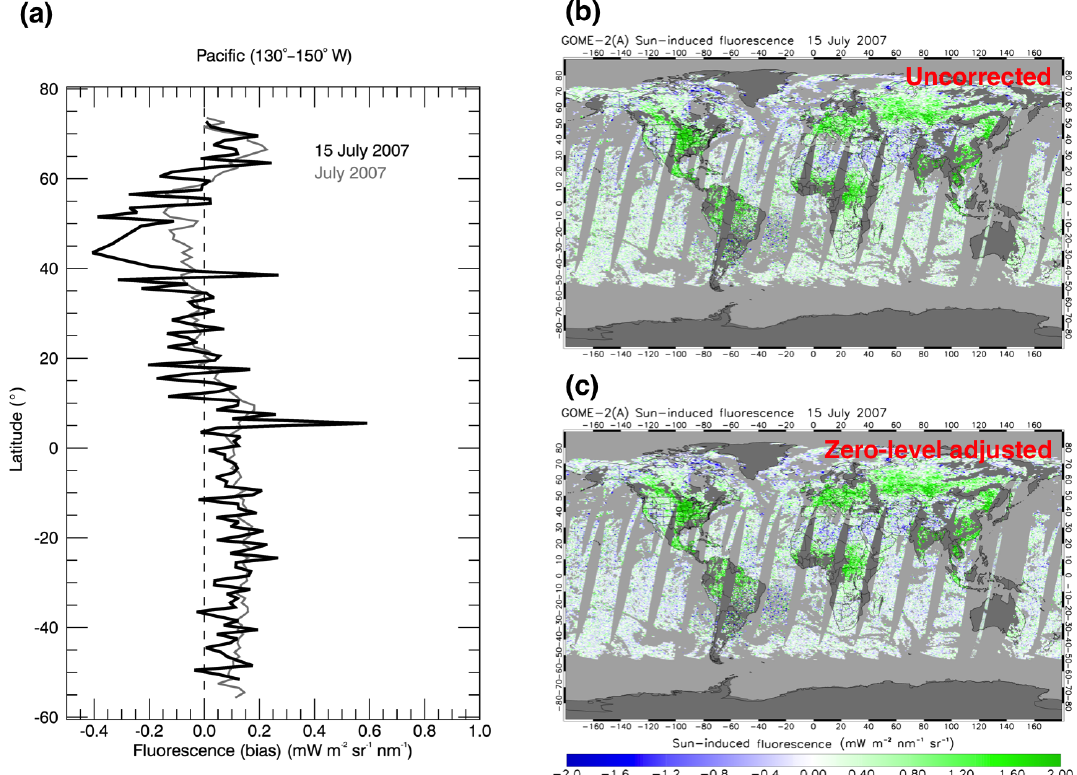
Figure 5. (a) Zero-level fluorescence found over the Pacific (130–150 ◦ W) on 15 July 2007 and averaged over July 2007, (b) level-2 SIF data on 15 July 2007 without zero-level adjustment, and (c) level-2 SIF data after the zero-level adjustment for 15 July 2007. The effect of the adjustment can be seen over the Southern Ocean, which after adjustment has SIF values close to 0mWm − 2 nm − 1 sr − 1